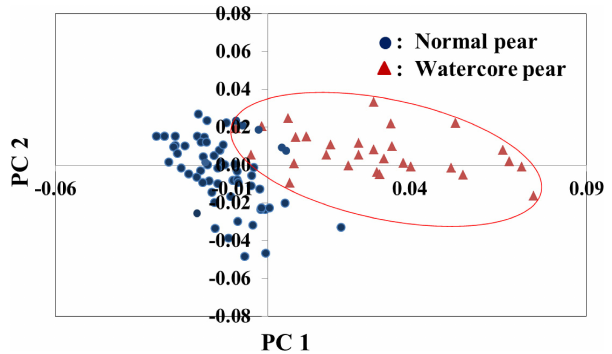
Fig. 11. Score plots PC1 and PC2 from discrimination model of watercore by PCA ( (cid:3) ¼ accepted pear , N ¼ rejected pear ).